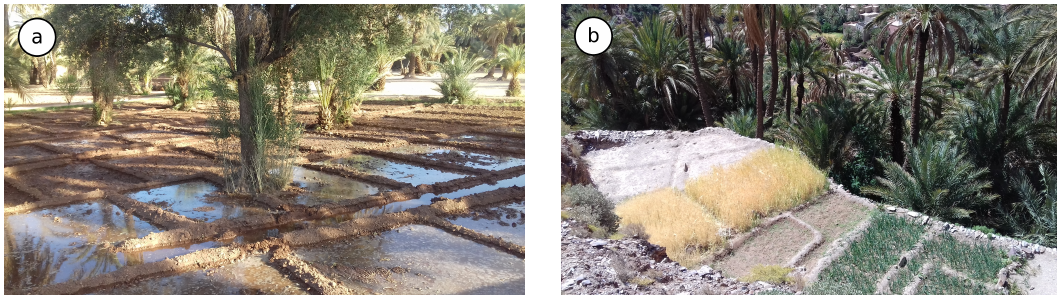
Figure 13. Traditional agricultural management in TAS: ( a ) flood irrigation of cultivated plots shaded by palms and other arboreal cultures. ( b ) Terrace subdivided in plots cultivated with different crops and